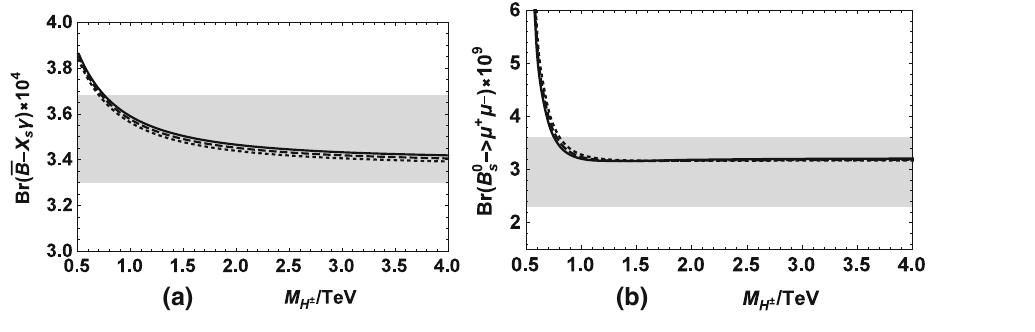
Fig. 8 Br ( ¯ B → X s γ) ( a ) and Br ( B 0 s → μ + μ − ) ( b ) versus M H ± for A t = − 2 . 5TeV ( solid line ), A t = − 0 . 5TeV ( dashed line ), A t = 1 . 5TeV ( dotted line ) , when tan β = 20 , m ˜ t = 3 . 5TeV. The gray area denotes the experimental 1 σ interval